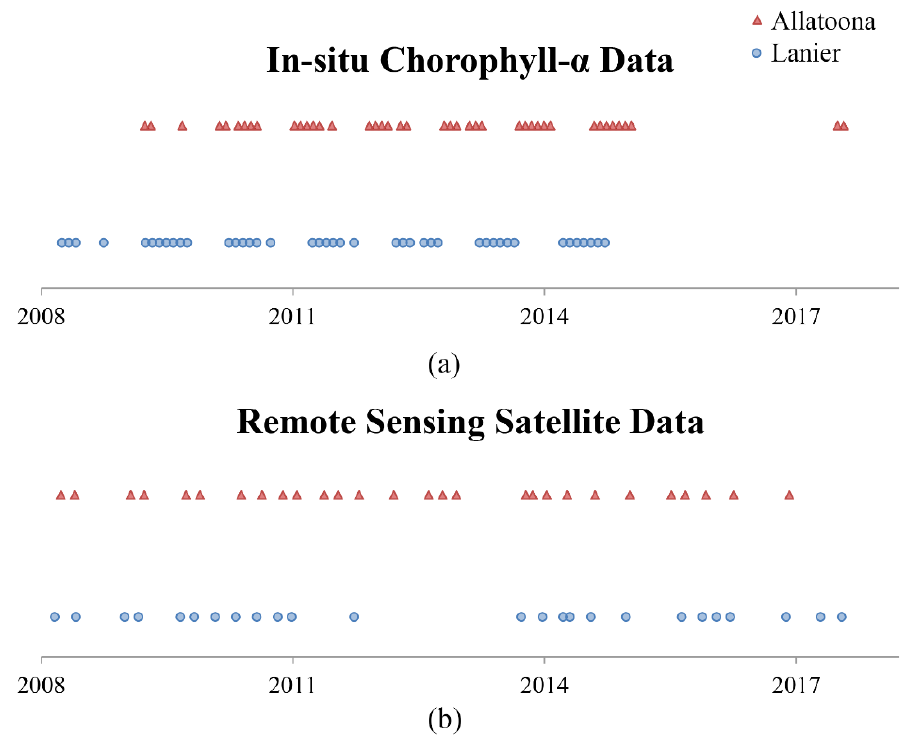
Figure A1. In situ and satellite remote sensing temporal coverage of phytoplankton bloom proxy data, from 2008 to 2017. (a) The majority of in situ data were gathered during similar dates; (b) Remote sensing data at Lake Lanier were more affected by cloud cover, resulting in fewer data points.